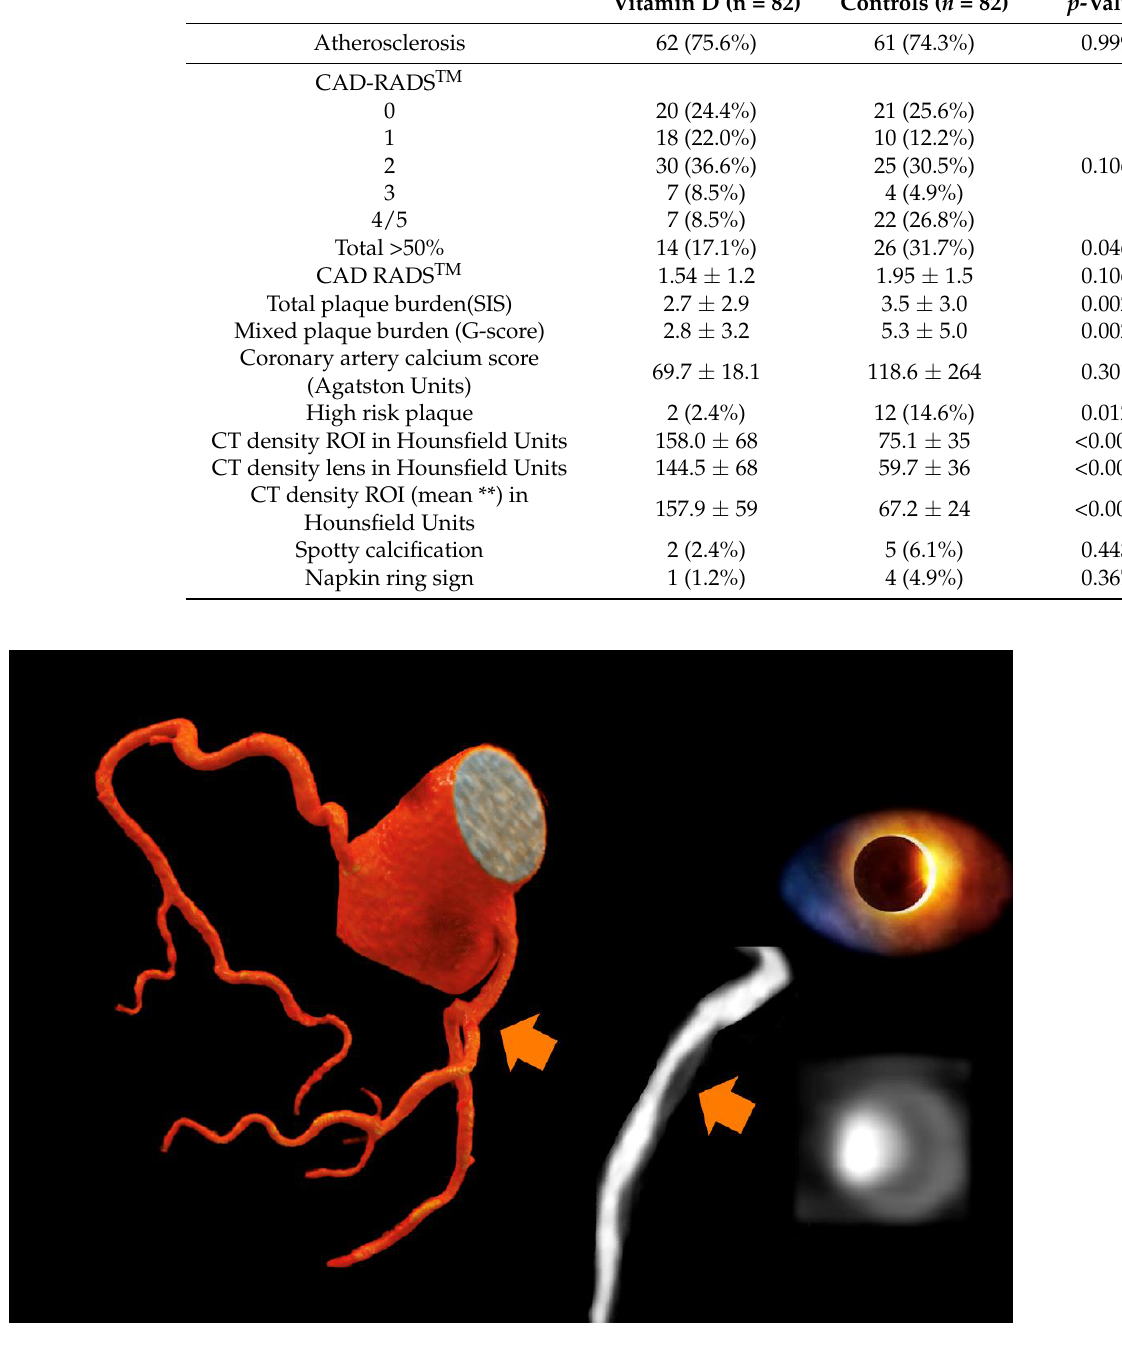
Figure 2. A 67 year-old-male with high-risk plaque (three criteria: low attenuation fibro-fatty plaque with lipid-necrotic core (4 HU), Napkin Ring Sign shown as outer hyperdense rim (lower left panel, orange arrow), and positive remodelling (remodelling index 1.5). Two cardiovascular risk factors (art hypertension and positive family history) and atypical chest pain. No vitamin D supplementation; coronary artery calcium score was zero.